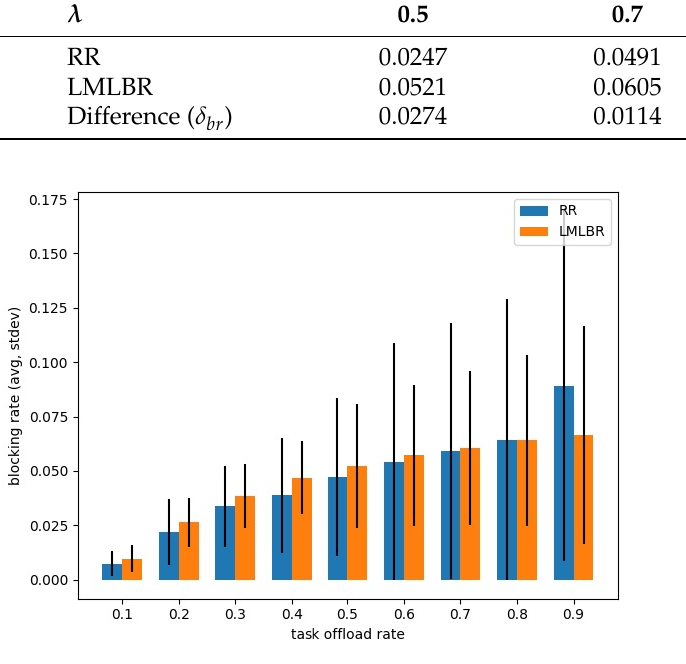
Figure 5. Comparison of RR and LMLBR in terms of the average task blocking rate. Each bar represents the average blocking rate at a given task offload rate. If we denote the average blocking rate as b and the standard deviation of the blocking rate as σ b , each line in each bar indicates the range of blocking rates from b − σ b to b + σ b